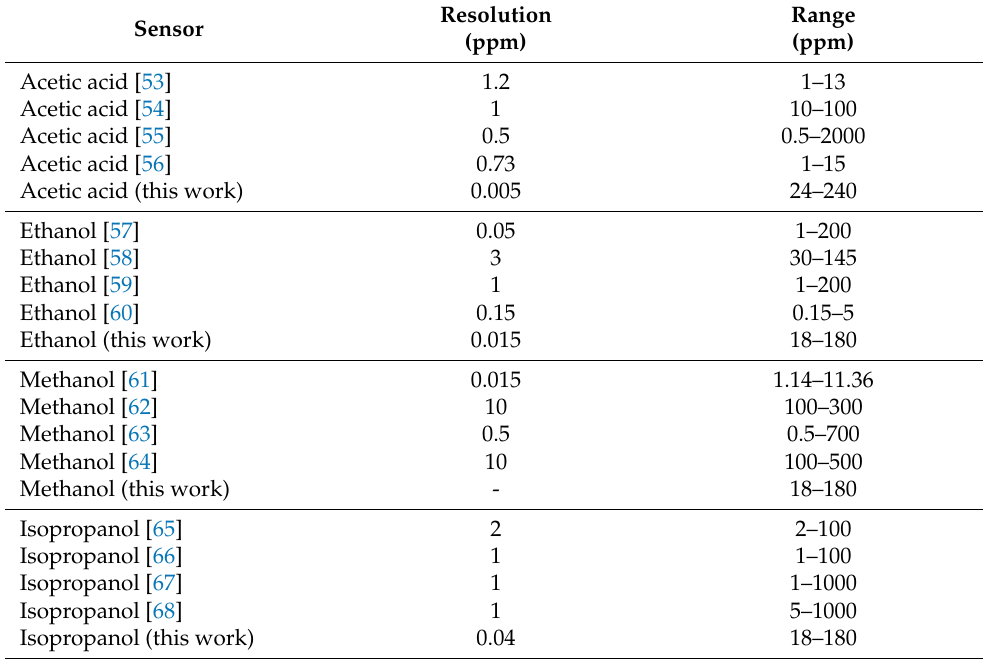
Table 3. Comparison of the achieved sensors with others available in